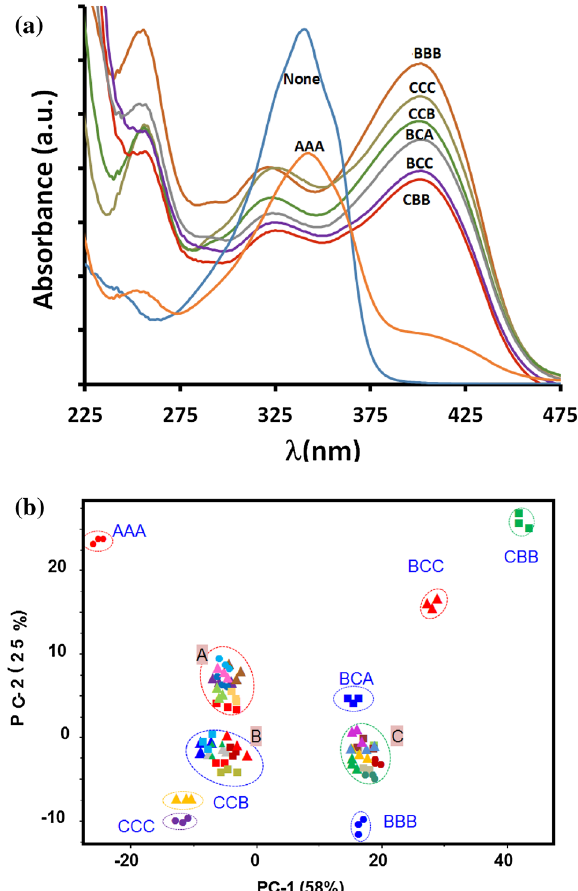
Figure 9. Absorption spectra of 5 ( a ) upon the addition of acetate (A), fluoride (B) and cyanide (C) in different combinations. ( b ) The corresponding PCA